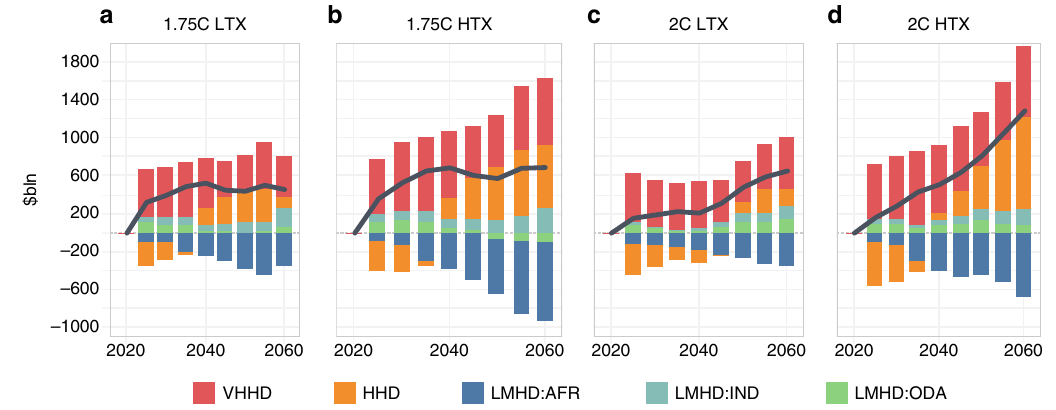
Fig. 2 Change in regional energy system costs and commodity trade costs under 1.75 and 2 °C HDI-based redistributed cases relative to optimal cases, 2020 – 2060. Panels a – d represent the change in energy system costs by HDI group, compared with the cost-optimal case. Negative values show a reduction in costs, while the black trend line shows the net change in global costs. Cost estimates do not include tax revenues raised by the production tax, with the focus on the techno-economic costs of the system. Source data are provided as a Source data fi le.